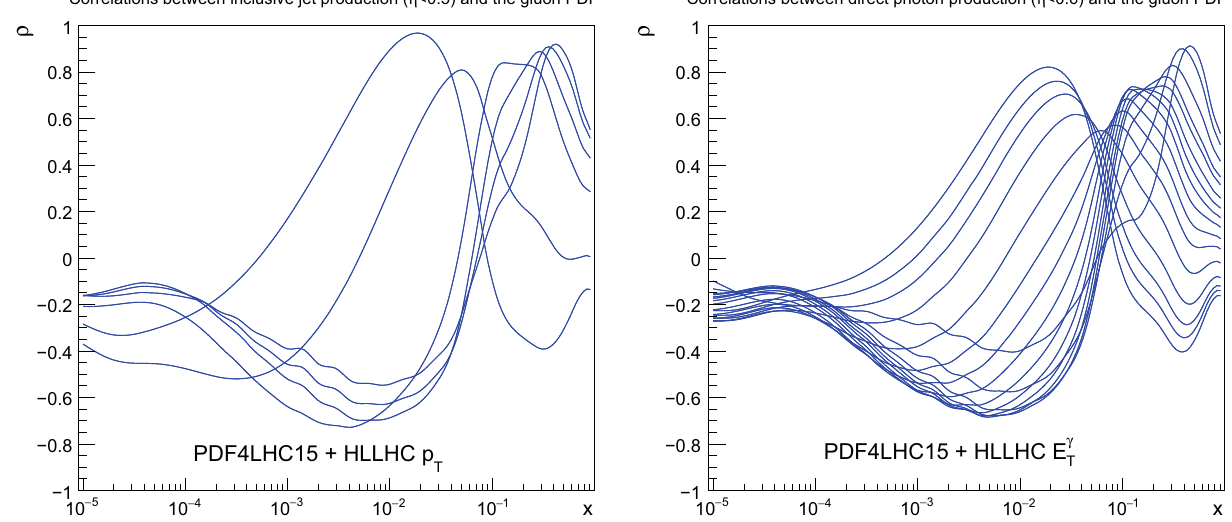
<0.5) and the gluon PDF η Correlations between inclusive jet production ( T